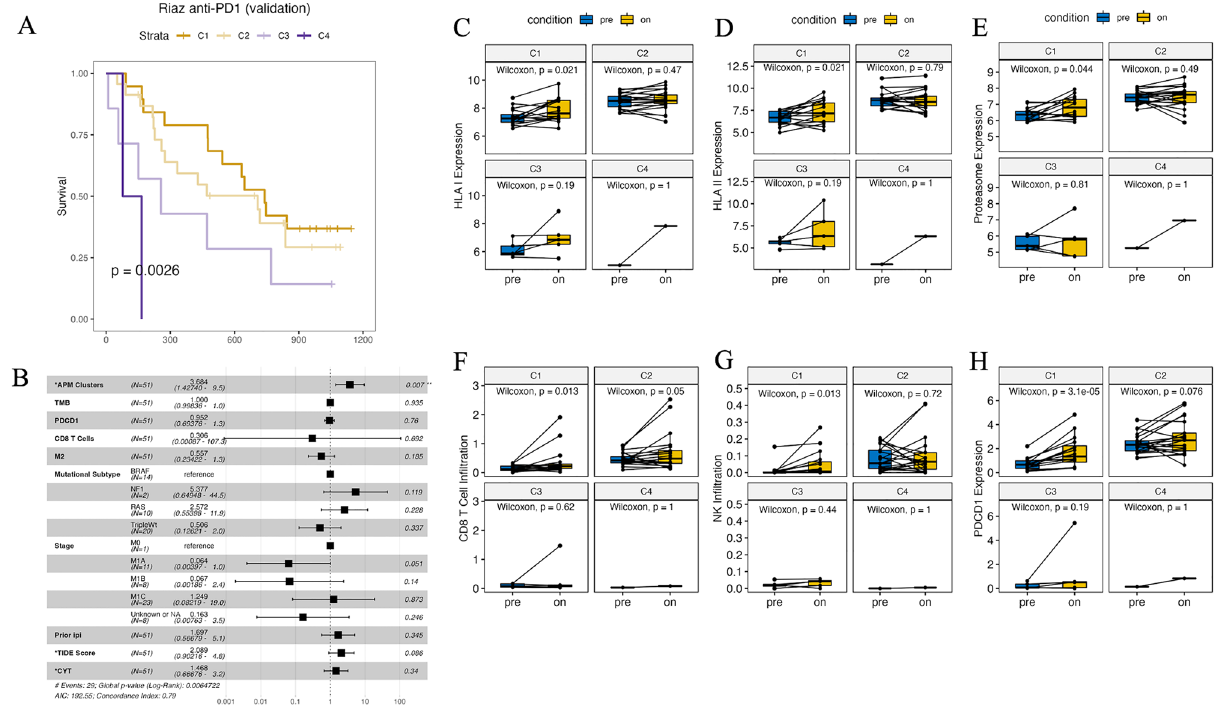
Figure 3. Differential regulation of APM and immune signatures across APM clusters during ICB. ( A ) Overall survival (OS) stratified by the predicted clusters (C1: n = 19, C2: n = 23, C3: n = 7, C4: n = 2) in the Riaz melanoma anti-PD1 cohort (n = 51, validation cohort) represented as Kaplan–Meier curves. P value was computed by Log-rank test. ( B ) Multivariate Cox proportional hazards model of APM clusters and clinical characteristics. APM clusters (C1 = 1, C2 = 2, C3 = 3, C4 = 4), tumor mutational burden (TMB), PDCD1 expression, CD8 T cell fractions, M2 fractions, prior ipi treatment (true = 1, false = 0), CYT, and the TIDE scores are continuous variables. Asterisks denote published signatures for predicting immunogenicity and prognosis to ICB. Hazard ratios (HR), 95% confidence intervals (CI), and p-values are shown. ( C–E ) HLA class I ( C ), class II ( D ), and proteasome expression ( E ) in pre-treatment tumors and matched on-treatment tumors across the clusters (C1: n = 16, C2: n = 21, C3: n = 5, C4: n = 1, excluding cases without on-treatment samples). Boxes in the boxplots represent interquartile ranges and vertical lines represent 5th–95th percentile ranges. Significance was computed by Wilcoxon signed-rank test. ( F,G ), As in ( C–E ) but for CD8 T cells ( F ) and NK cells ( G ). ( H ) As in ( C–E ) but for PDCD1